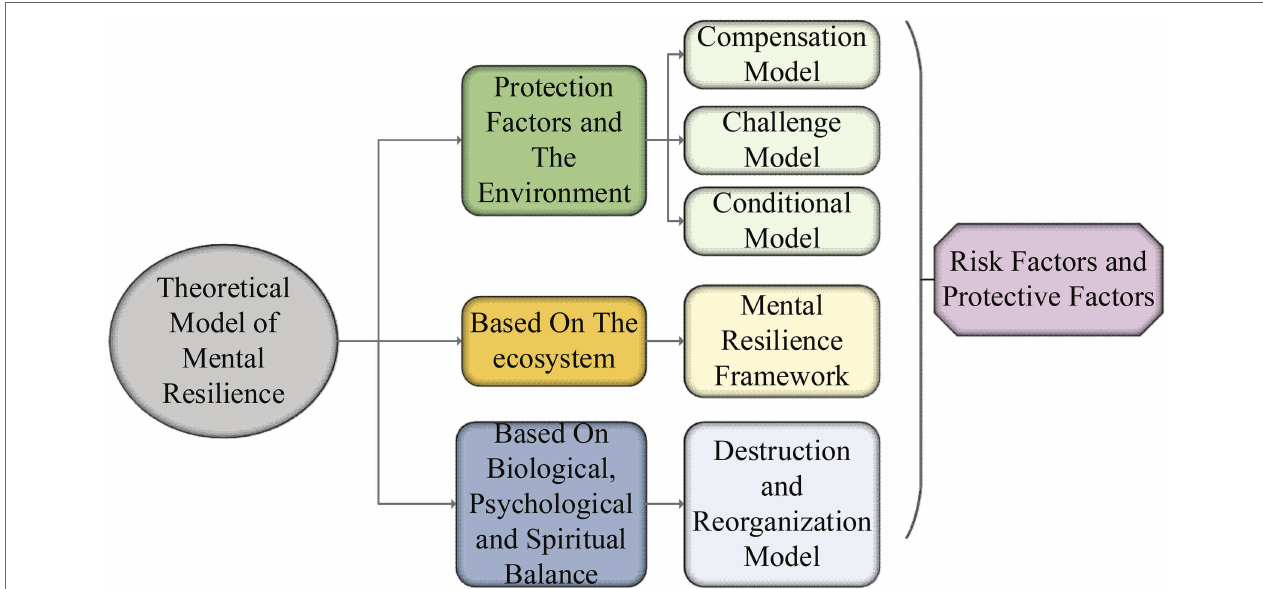
FIGURE 3 | The dimension division of psychological